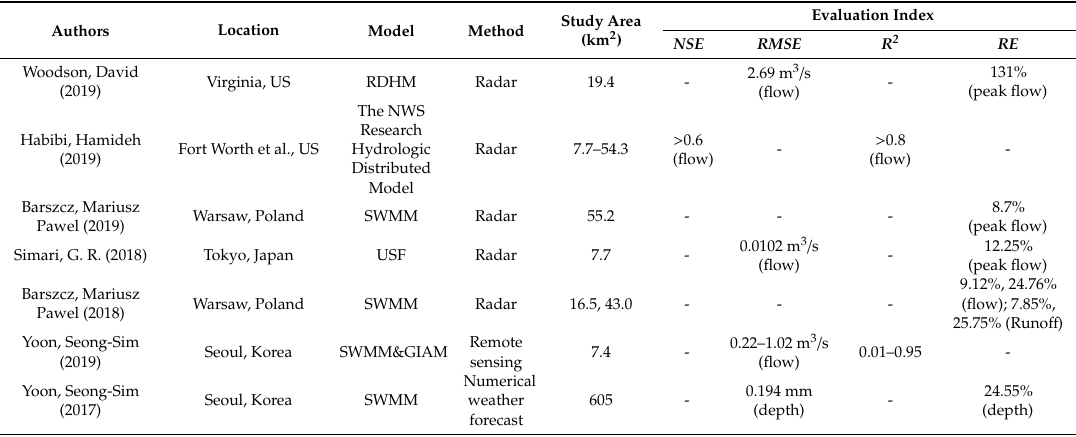
Table 4. New technology rain test statistics table [17,62–67].